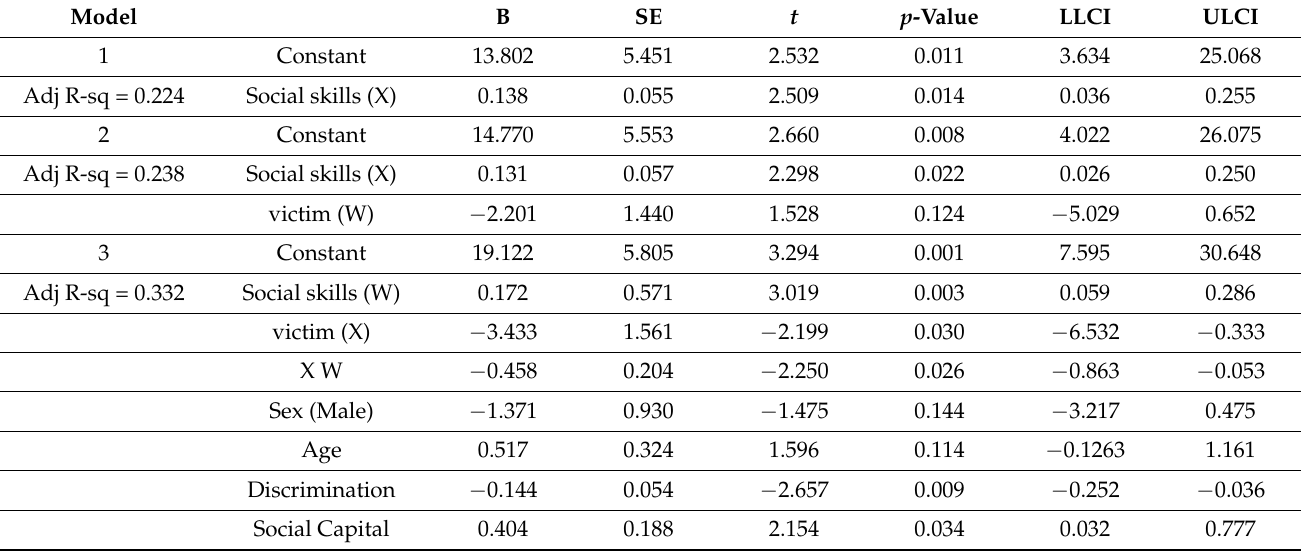
Table 4. Various models estimating self-esteem